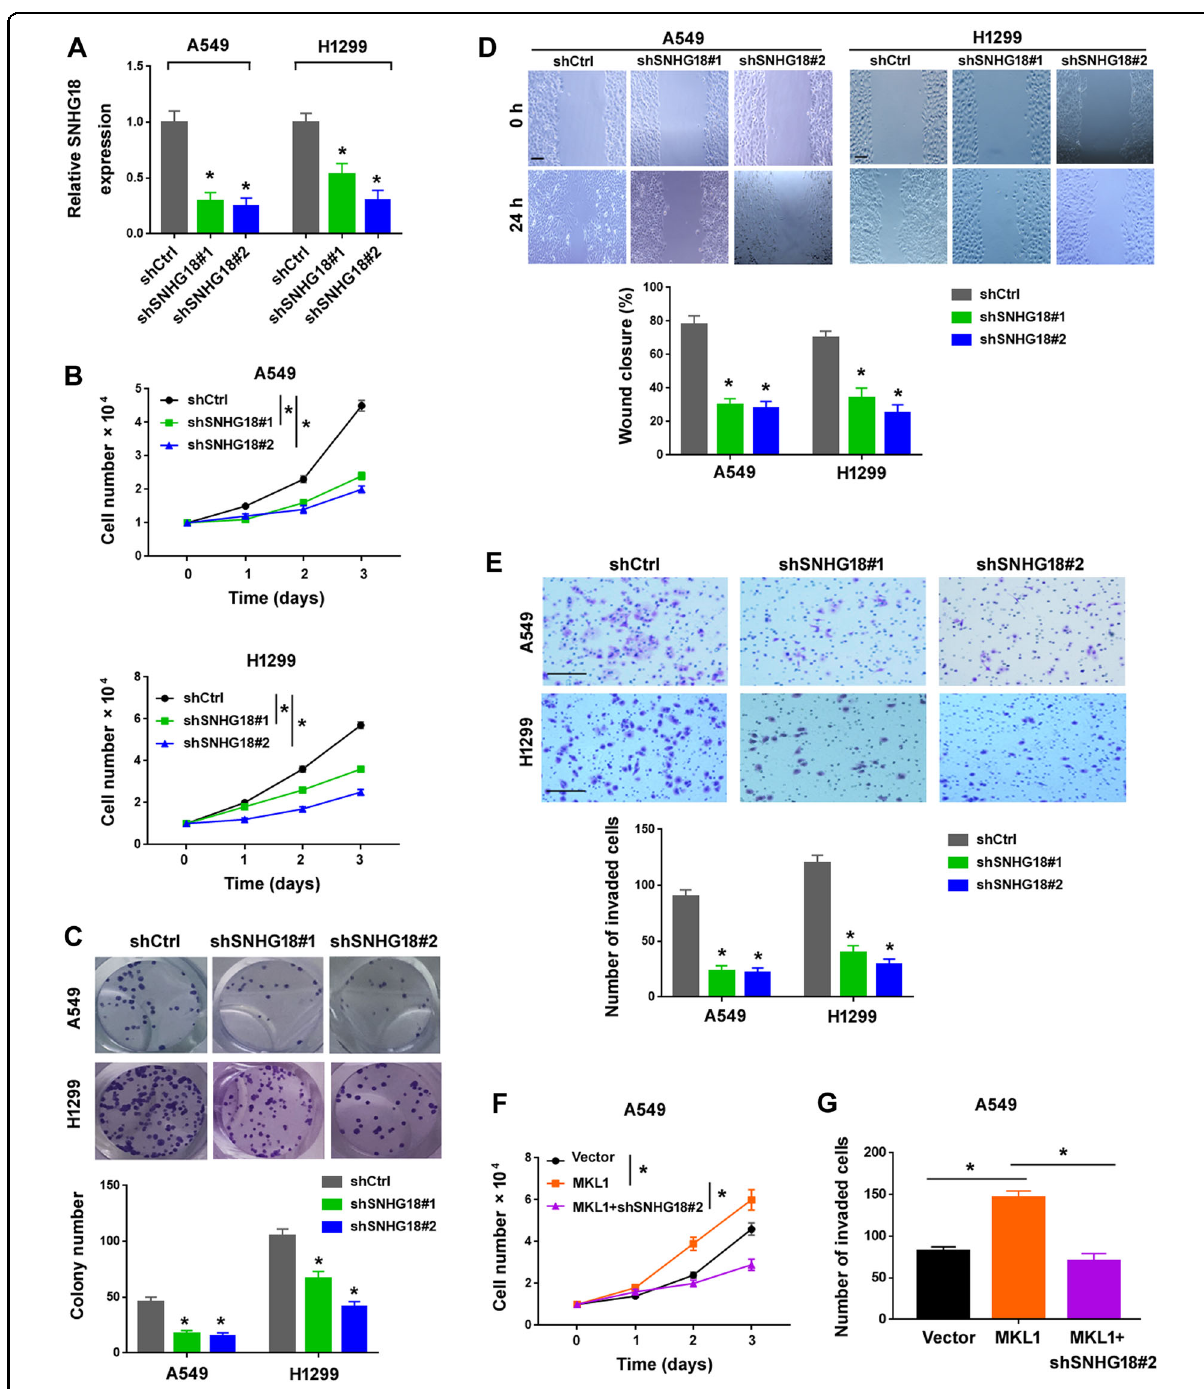
Fig. 3 SNHG18 knockdown suppresses MKL1-induced growth and invasion of NSCLC cells. A Quantitative PCR analysis of SNHG18 expression in NSCLC cells transfected with negative control shRNA (shCtrl) or two different shRNAs targeting SNHG18 (shSNHG18#1 and shSNHG18#2). n = 3. B The proliferation of NSCLC cells transfected with indicated shRNAs was analyzed by direct cell counting. n = 4. C SNHG18 knockdown reduced the capability of clone formation by NSCLC cells. n = 3. D SNHG18 knockdown inhibited the migration of NSCLC cells, as determined by wound-healing assay. Bottom, bar graphs showing the quantitative results from three independent experiments. Scale bar = 300 μ m. n = 3. E Reduction of cell invasion in NSCLC cells transfected with indicated shRNAs. Scale bar = 100 μ m. * P < 0.05 vs. shCtrl. n = 3. F K n ockdown of SNHG18 blocked MKL1- induced cell proliferation in A549 cells. n = 4. G Assessment of cell invasion in A549 cells transfected with indicated constructs. * P < 0.05. In all panels, one-way ANOVA and Bonferroni ’ s tests were performed. n =